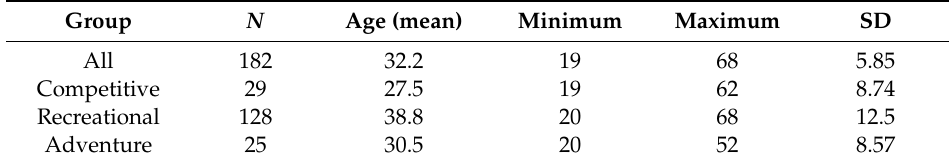
Table 1. Descriptive statistics for the questionnaire sample.